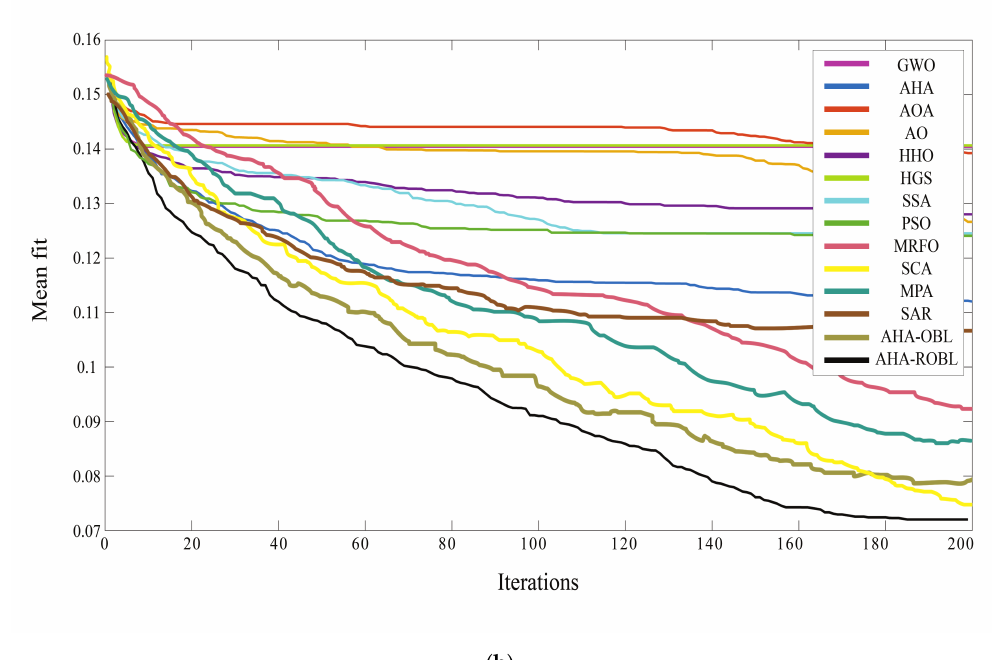
Figure 6. ( a ) Convergence curve of the AHA-ROBL and AHA-OBL versus other algorithms using VGG19 and ( b ) convergence curve of the AHA-ROBL and AHA-OBL versus other algorithms using